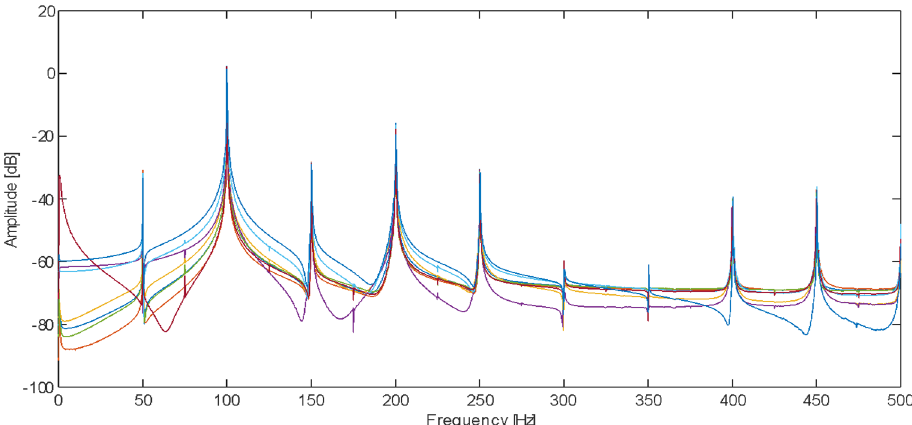
Figure 6. PSD functions at the second reference point from all partial experiments.